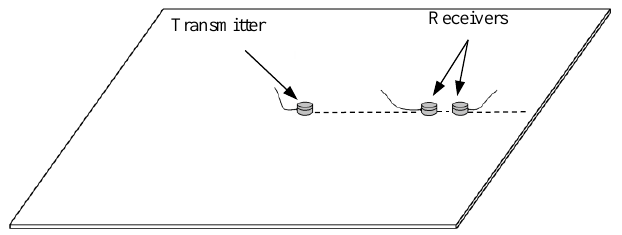
Figure 4. Schematic of the test setup.